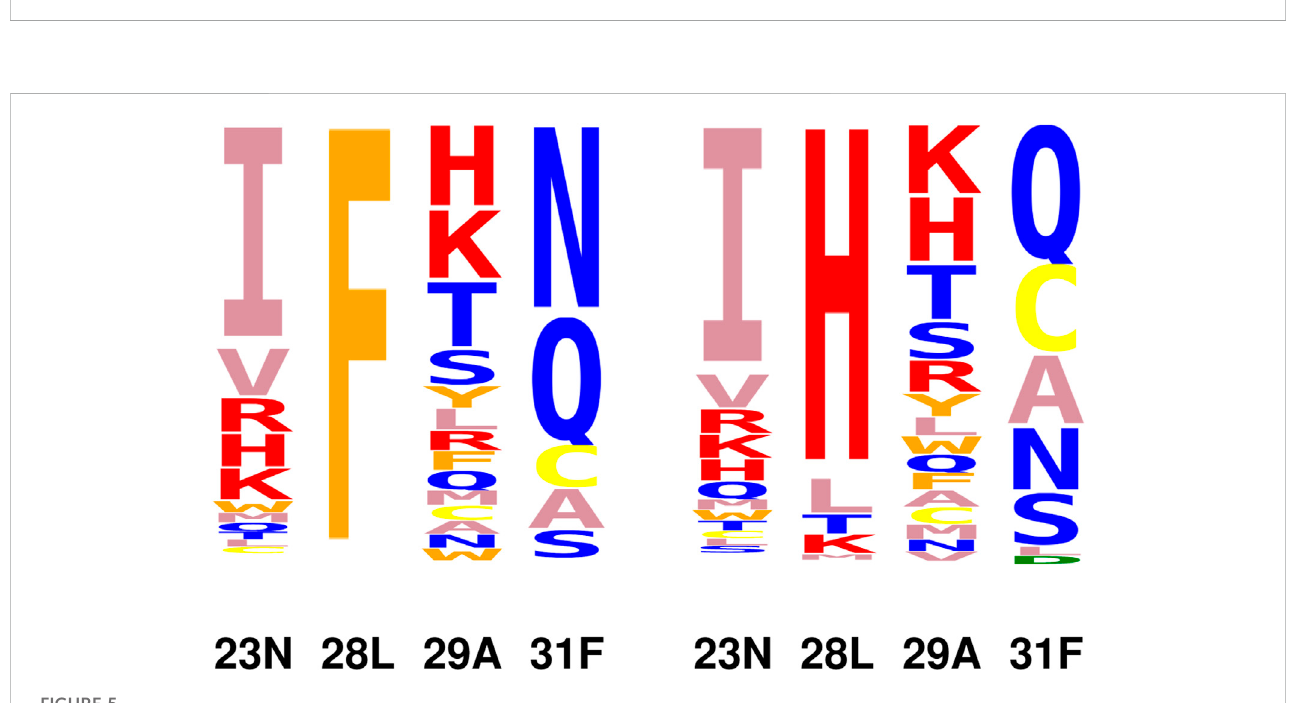
FIGURE 5 Vitality logos from quartet redesign. Right: variants with F28